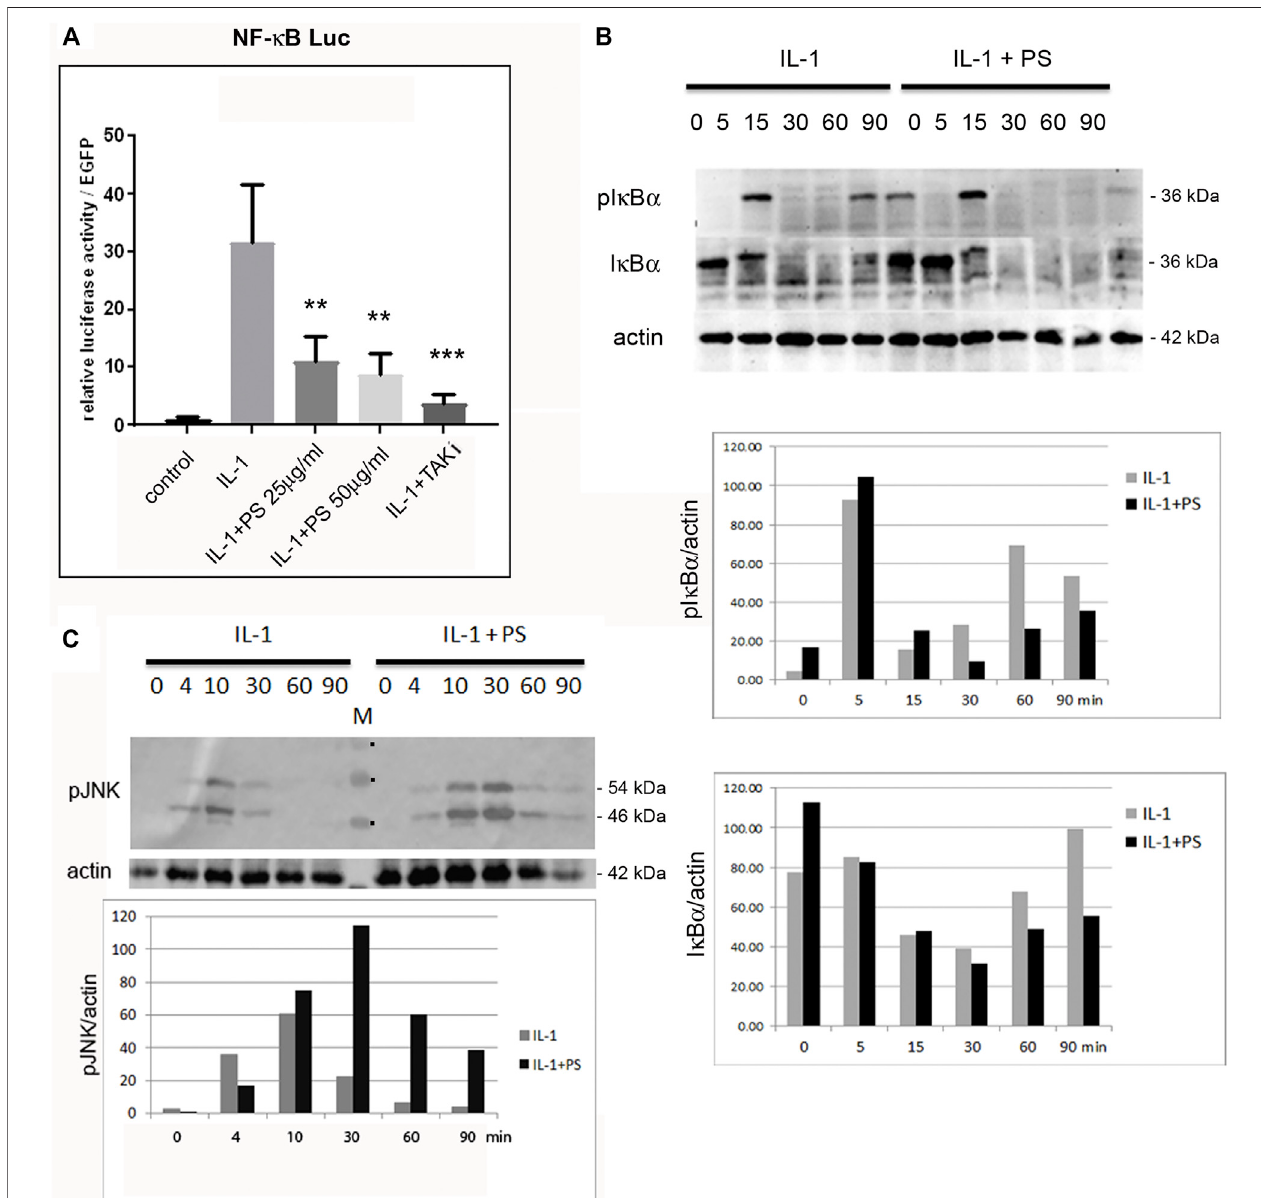
FIGURE2| PSinhibitstheNF- κ B,butenhancestheJNKactivity. (A) HUVECweretransfectedwithaNF- κ Bluciferasereporterconstruct(NF- κ Bluc)andEGFPas internal control, pretreated for 30 min with 25 or 50 μ g/ml PS or 5 μ M TAK1 inhibitor (TAKi) as positive control and stimulated with 5 ng/ml IL-1. Control: unstimulated cells. Luciferase levels were determined after 16 h and are shown as relative luciferase levels normalized to EGFP. Triplicate samples were analyzed. ** p < 0.01, *** p < 0.001 as compared to IL-1 stimulation; (B) HUVEC were either treated with 5 ng/ml IL-1 alone (left) or pre-incubated with 50 μ g/ml PS for 30 min following stimulation with IL-1 (right) for the indicated times and analyzed for phospho-I κ B α , I κ B α , and β -actin by Western blotting. Approximate MWs of the proteins are given on the right. A quanti fi cation is given below. (C) Western analysis of HUVEC treated with 50 μ g/ml PS for 30 min followed by stimulation with 5 ng/ml IL-1 for the indicated times in minutes. Samples were analyzed for phospho-JNK (pJNK) and β -actin. The approximate MW of the two pJNK bands are indicated on the right. M: marker, the three visible bands of 40, 55 and 70 kDA are indicated by dots. Lower panel: quanti fi cation of pJNK (average of the p46 and p54 bands) normalized to β -actin.